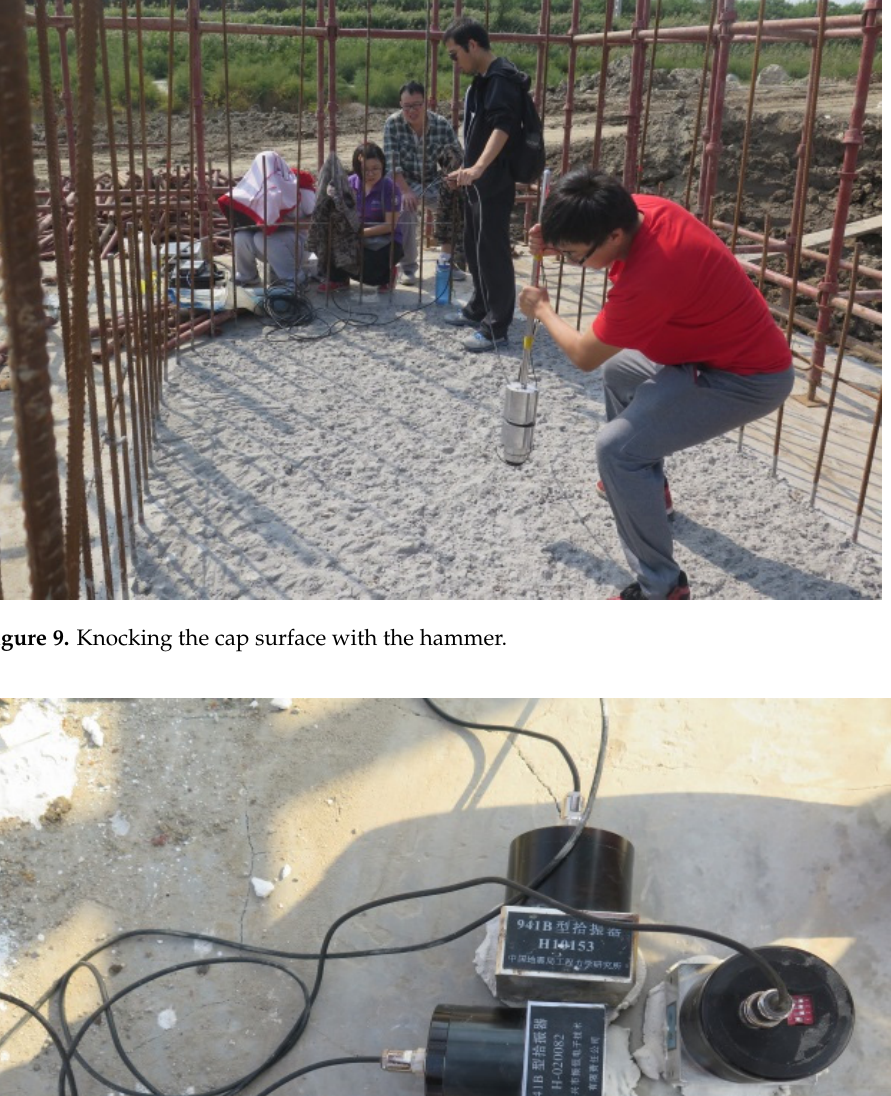
10 of 14 Figure 8. Distribution of the soil layers. During the test, a high-elastic cohesive hammer was used to impact the designated position of the pile cap for excitation (as shown in Figure 9), and the responses of the foundation could be acquired by installing a series of vibration sensors (Figure 10) on the top of the cap. There were three working conditions in the test: (1) Impact the top of the cap in a vertical direction and obtain its vertical acceleration response; (2) Impact the north side of the cap and obtain its acceleration response in a north– south direction; (3) Impact the east side of the cap and obtain its acceleration response in an east–west direction. The type of hammer and the data acquisition instrument were DFC-1 and INV3018A, respectively—both from the China Orient Institute of Noise & Vibration. The